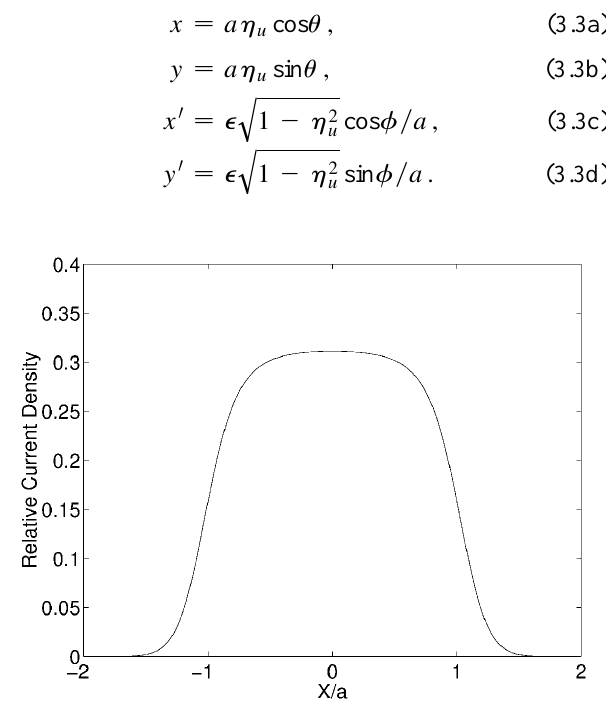
FIG. 1. The beam profile distribution function [Eq. (3.1)] plotted at y (cid:1) 0 using L (cid:1) 2